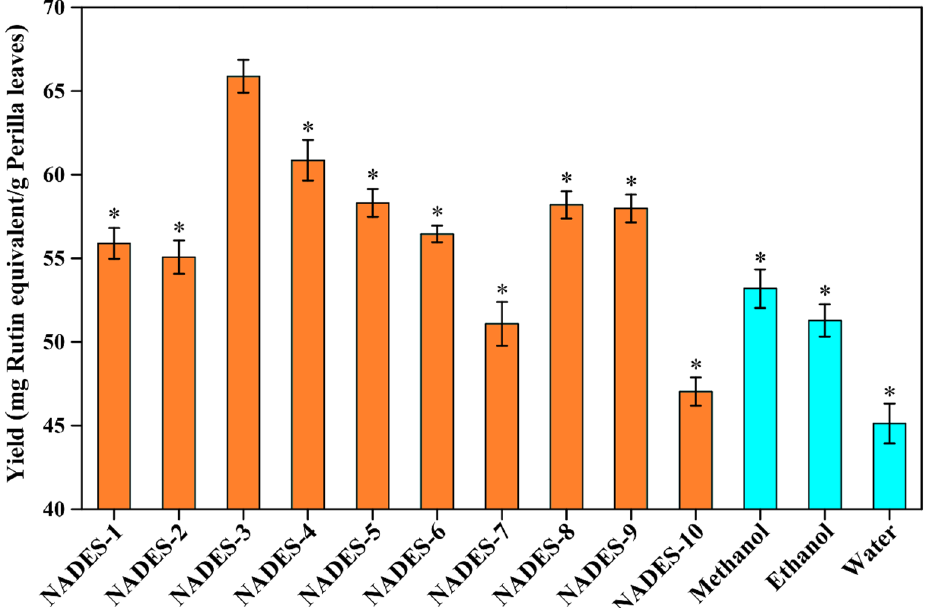
Figure 1. The extraction yields of total flavonoids from perilla leaves by using different types of NADESs. The preferred test conditions were as follows: water content in the NADES systems, 30% ( w / w ); extraction power, 300 W; extraction time, 20 min; solid–liquid ratio, 100 mg/mL. The * indicates that yields of total flavonoids were significantly different from NADES-3 ( p <